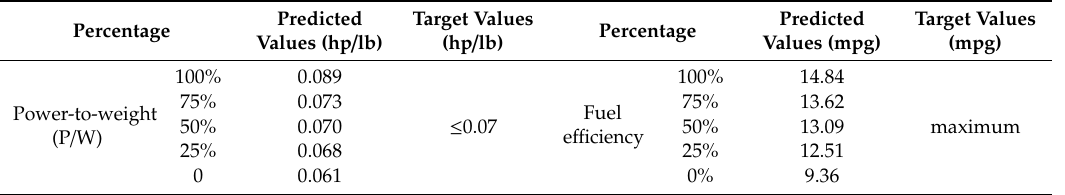
Table 7. Target design variable values 3 for a roadable PAV.